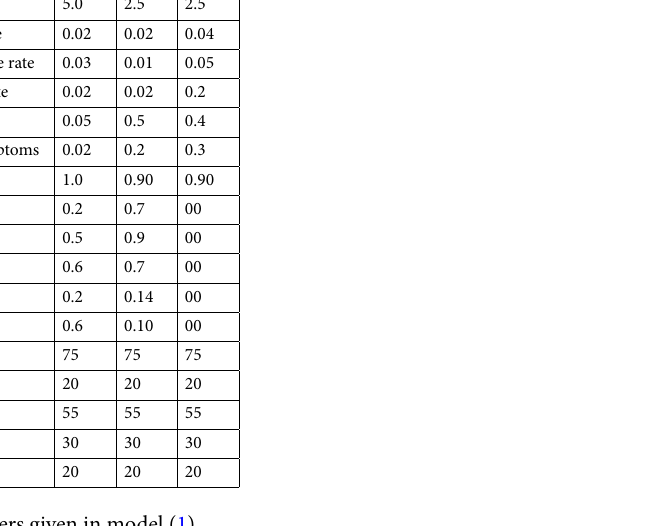
Table 2. The values for parameters given in model